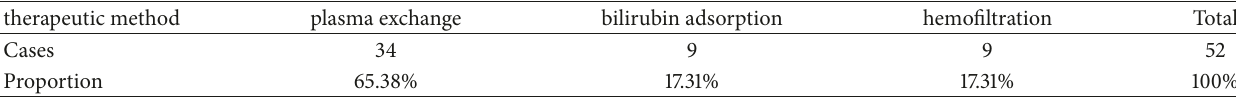
Table 4: Classification of nonbioartificial liver models.